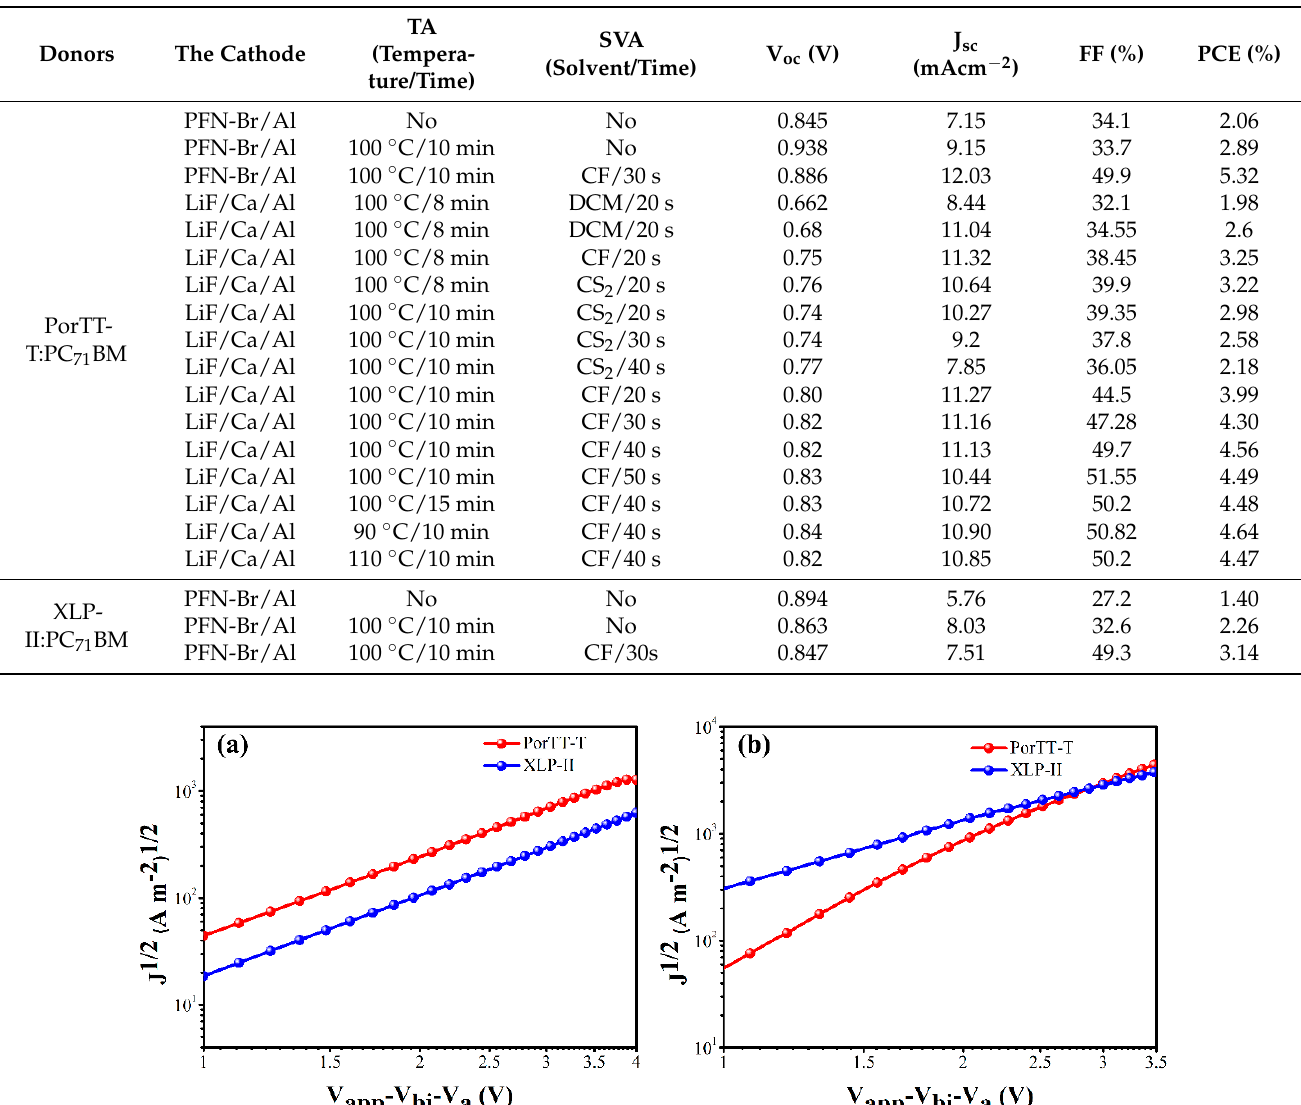
Table 4. Photovoltaic performance of bulk heterojunction solar cells based on donor (PorTT-T/XLP-II):PC 71 BM with weight ratios of 1:1.2 cast from CB and different post-treatments using PFN-Br/Al and LiF/Ca/Al as the cathode under AM1.5G illumination (100 mW · cm − 2 ).